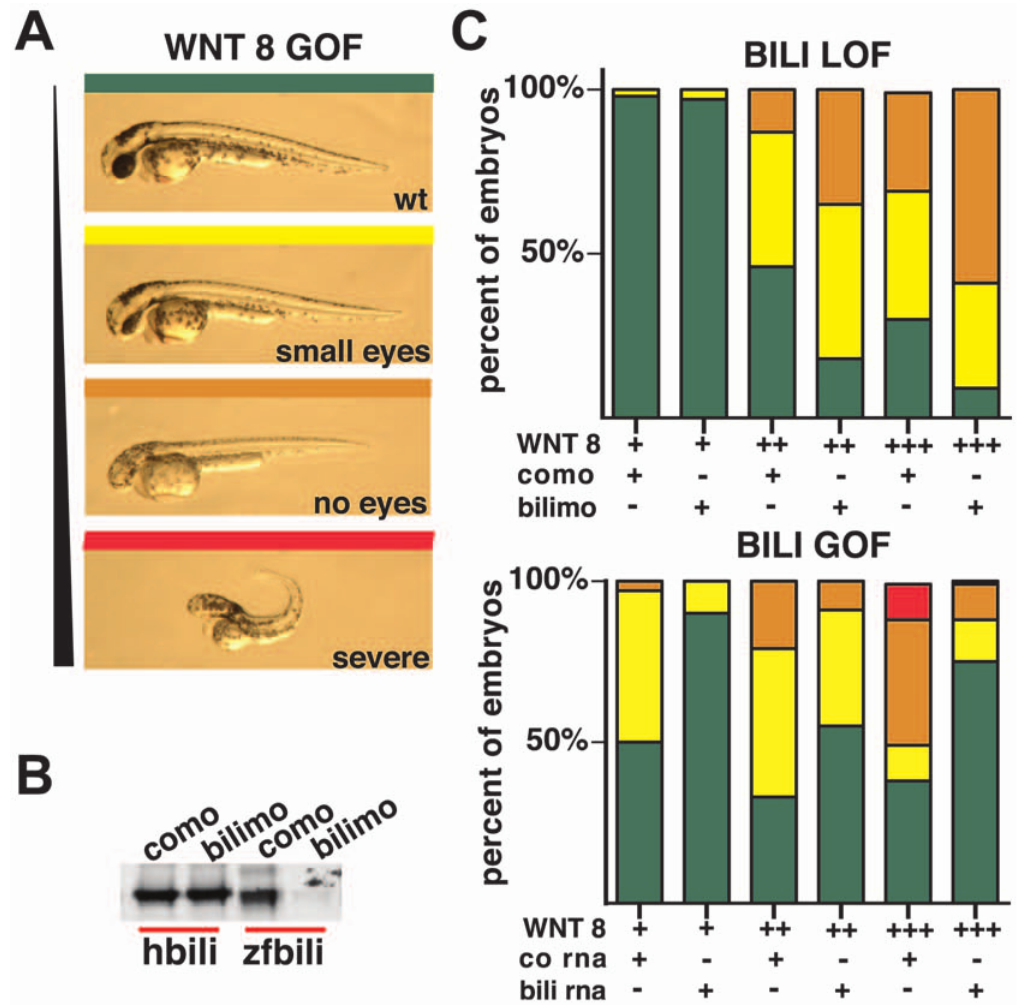
Figure 3. Bili’s effect on Wnt signaling is conserved in zebrafish. (A) Wnt8 overexpression phenotypes with increasing severity. Embryos were scored as wt (green), small eyes (yellow), no eyes (orange) or severe (red). (B) Morpholino effect on in vitro expression of human Bili (hBili) or zfBili protein (control (como) or zfBili morpholino (bilimo)). (C) In the top panel, the effect of bilimo (loss of function) on Wnt8 GOF phenotype compared to como, is shown (n=73 low Wnt dose, n=147 medium Wnt dose, n=57 high Wnt dose). Bili GOF (bili rna) rescues Wnt8 overexpression phenotype (control Renilla (co rna)). (n=125 per dose of Wnt8) (bottom panel).